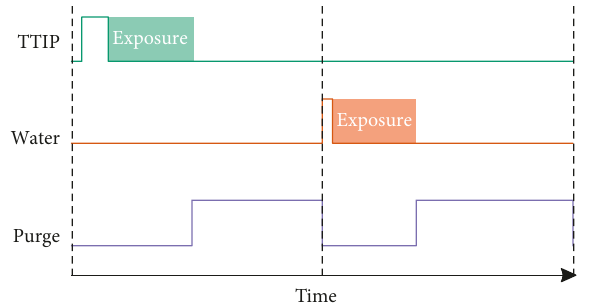
Figure 2: ALD time-step cycle plot with each precursor pulse, exposure, and purge steps over